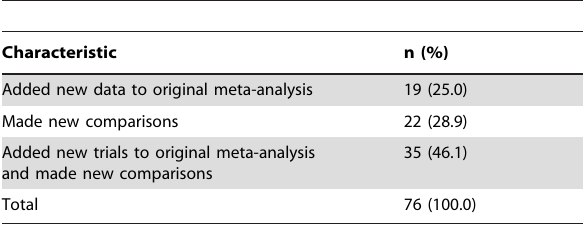
Table 4. Characteristics of updated reviews that included additional trials at first update (76